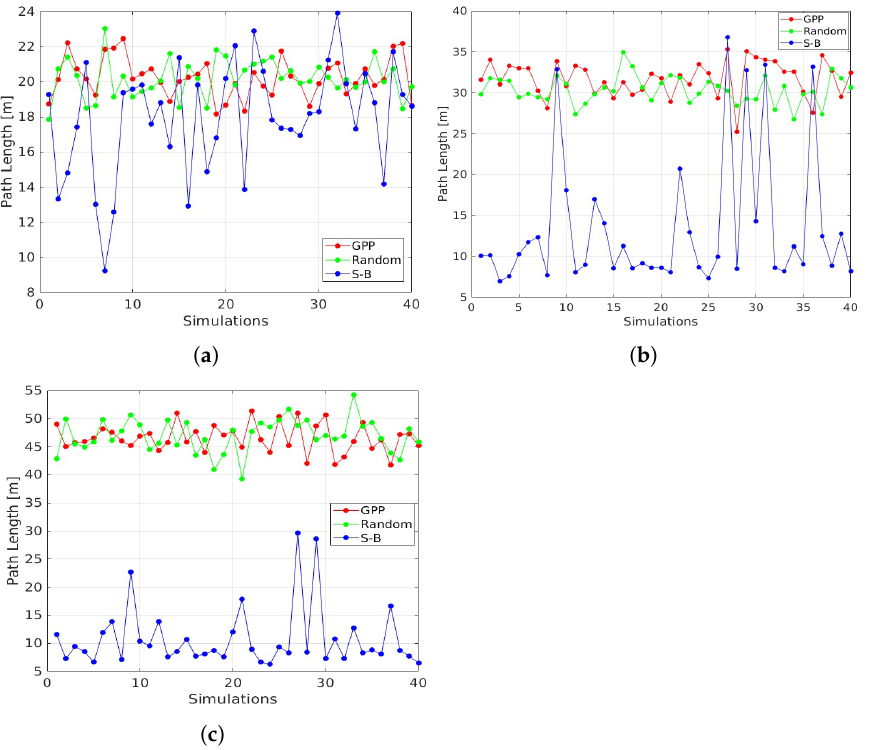
Figure 9. Path Length metric over 40 offline executions in scenario 1. ( a ) Area 1; ( b ) Area 2; ( c ) Area 3.